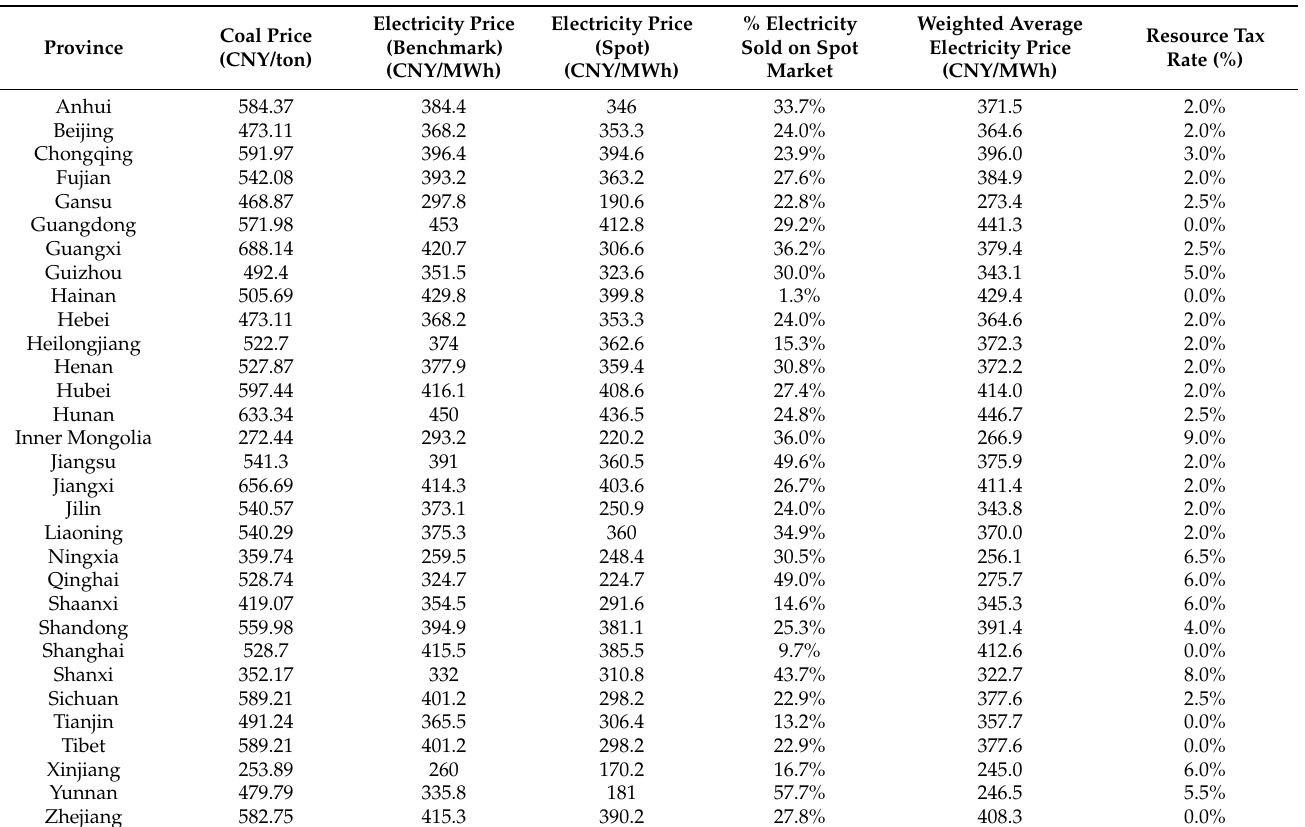
Table A16. Average coal [98] and electricity prices [99] (2019, incl. VAT), and resource tax rates [100], by